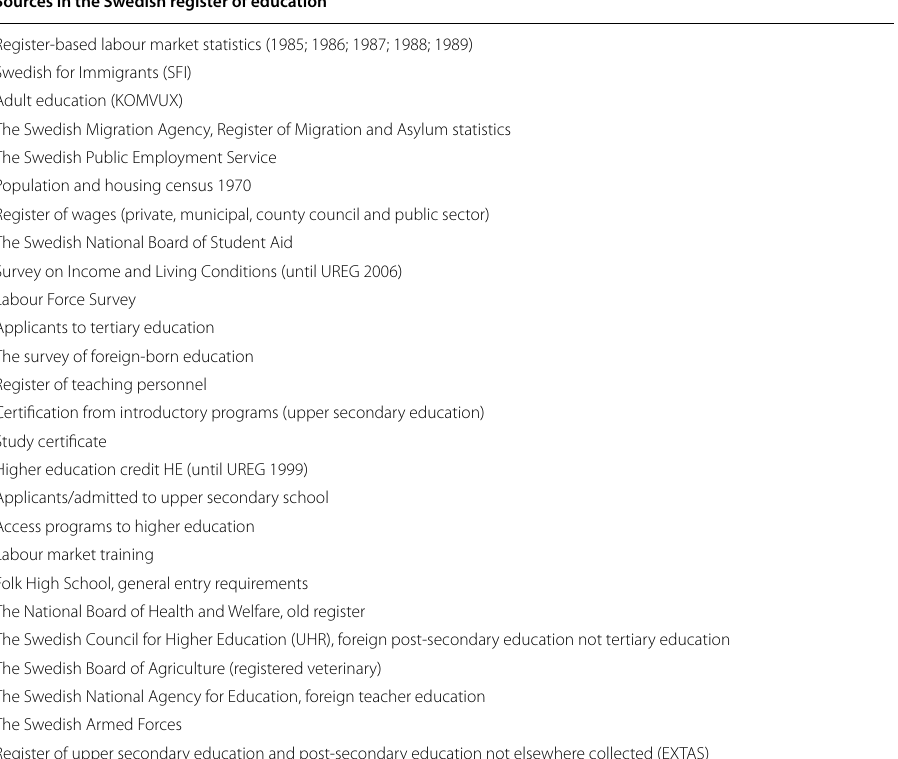
Table 5 Sources of education collected by